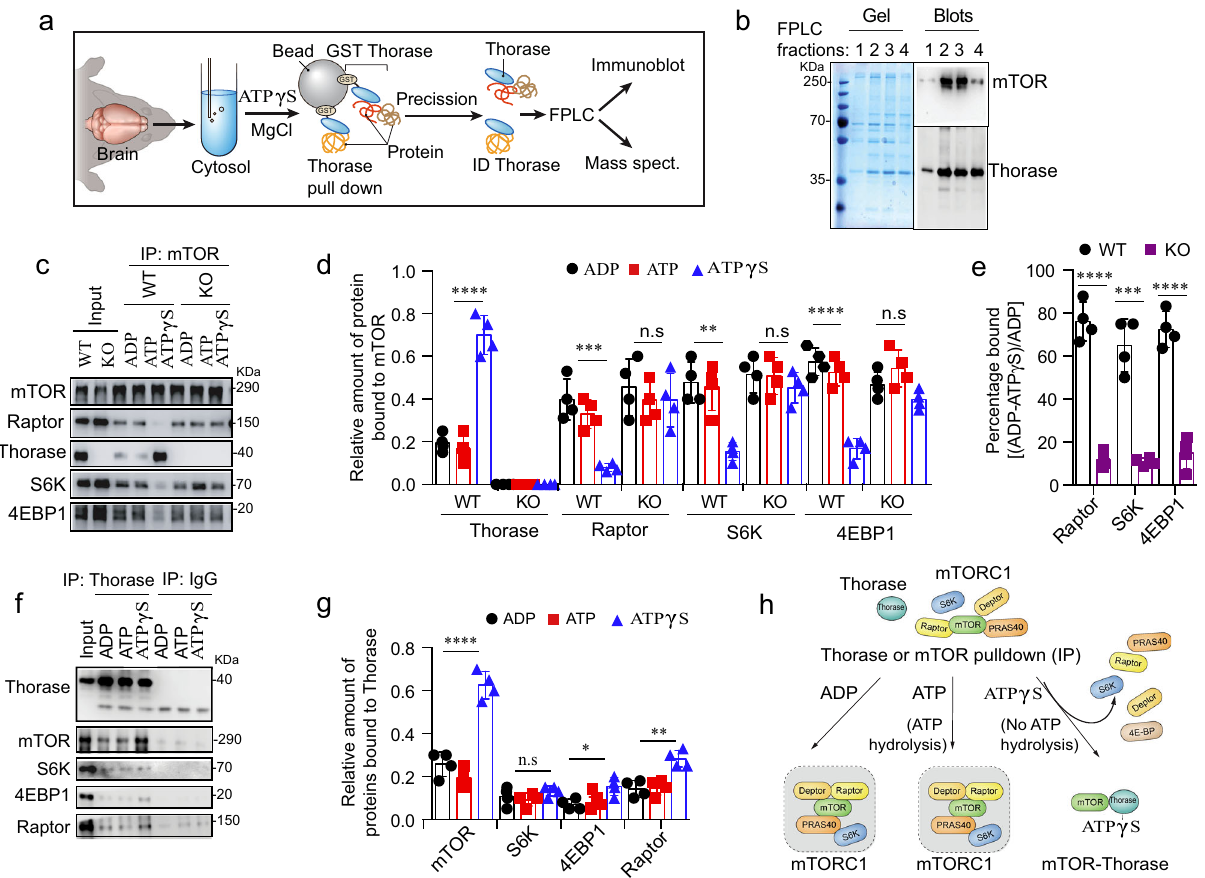
Fig. 1| Thoraseinteraction withmTORisconcomitant toadecreaseinbinding of mTOR to other mTOR complex 1-related proteins. a Schematic diagram of recombinantThorasepulldownfrombrainlysatestoidentifynovelbindingpartners through mass spectrometry. b SDS-PAGE and immunoblots of FPLC fractions of Thorase pulldown of mTOR. c Immunoblot images of mTOR pulldown from wild type (WT) or Thorase knockout (KO) brain lysates in the presence of different nucleotides. d Quanti fi cation of blots in c ( n =4 independent pull-down assays). e Graphical representation of percent disassembly of mTORC1-related proteins in c ( n =4independentpull-downassays). f Immunoblotimagesofimmunoprecipitation